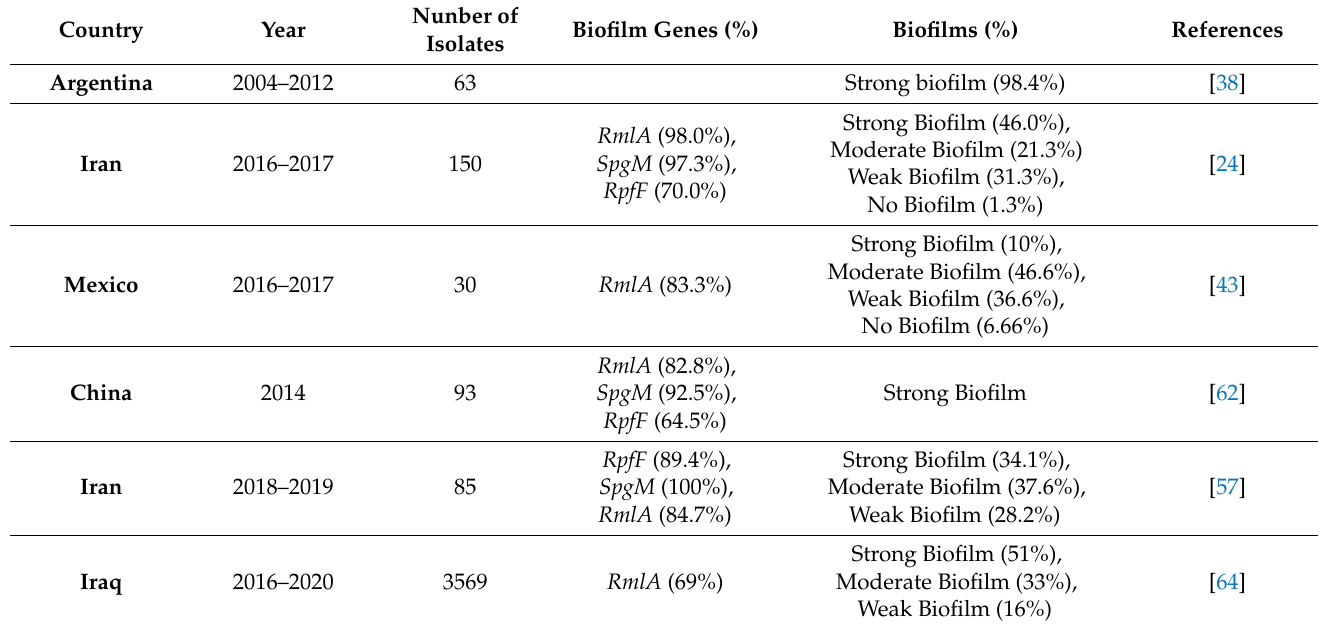
Table 3. Ability to form biofilms with S. maltophilia and associated